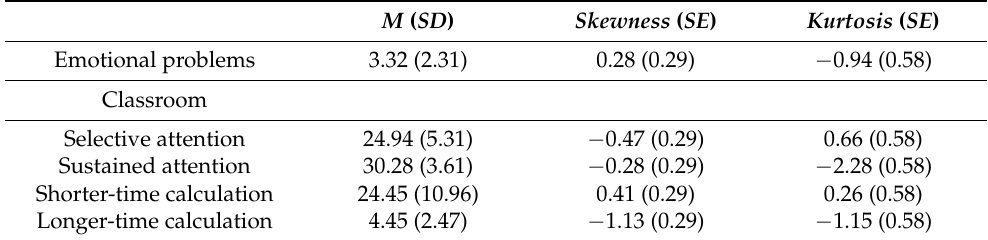
Table 1. Descriptive statistics for all variables for the entire sample and by environment (N =